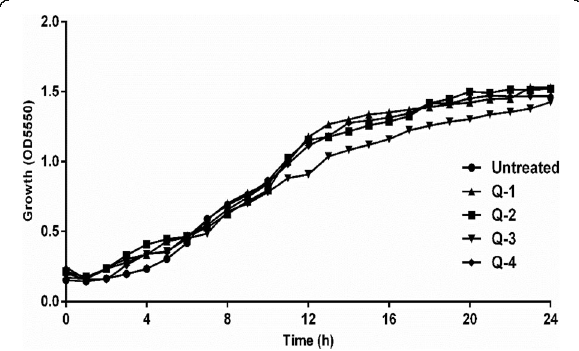
Fig. 1 Growth curve of P. aeruginosa isolates in the presence of Q. infectoria gall extracts over 24 h; points denote means from three biological replicas. Q-1: ethyl acetate, Q-2: n-butanol, Q-3: ethanol, Q-